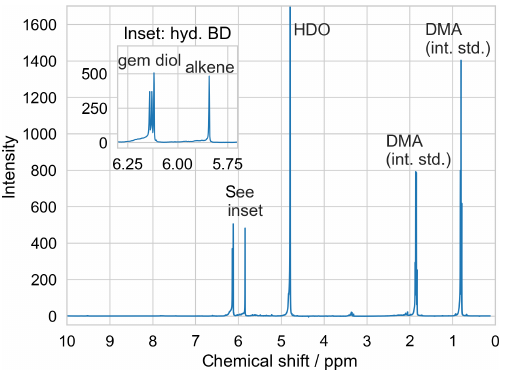
Figure 3. NMR spectrum of synthesized butenedial in deuterated water solvent. Includes peaks associated with hydrated butenedial (hyd. BD), diethylmalonic acid (DMA), used as an internal standard (int. std.), and solvent (HDO).